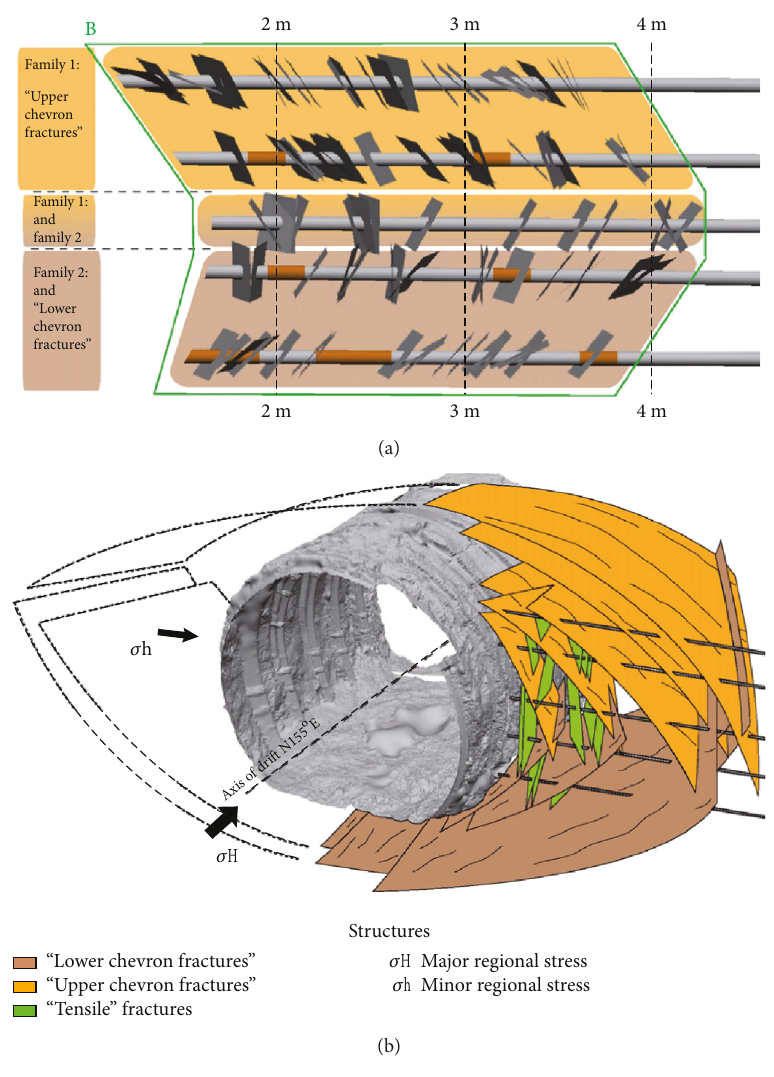
Figure 12: Borehole observation of excavation-induced fractures (a) and the fracture network by extrapolating the observed fractures (b) around a circular tunnel at Meuse/Haute-Marne Underground Research Laboratory